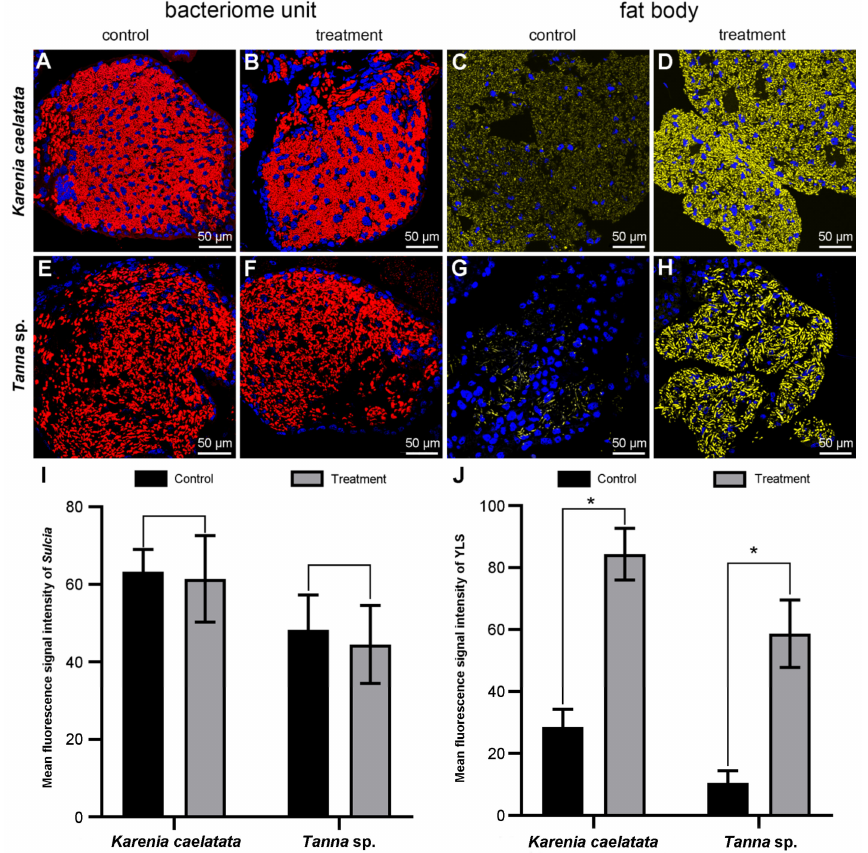
Figure 6. Fluorescence microscopy showing the fluorescence signal intensity of Sulcia and YLS based on different treatments for Karenia caelatata and Tanna sp. ( A , B ) Sulcia in the bacteriomes of K. caelatata. ( C , D ) YLS in the fat bodies of K. caelatata. ( E , F ) Sulcia in the bacteriomes of Ta. sp. ( G , H ) YLS in the fat bodies of Ta. sp. ( I ) Compared analysis of the fluorescence signal intensity of Sulcia between control groups and treatment groups. ( J ) Compared analysis of the fluorescence signal intensity of YLS between control groups and treatment groups. Control, without addition of helpers and heat shock. Treatment, with addition of helpers into hybridization buffer combined with 95 ◦ C heat shock of hybridization sections for 2 min before hybridization. Asterisks (“*”) representing the significant differences between control groups and treatment